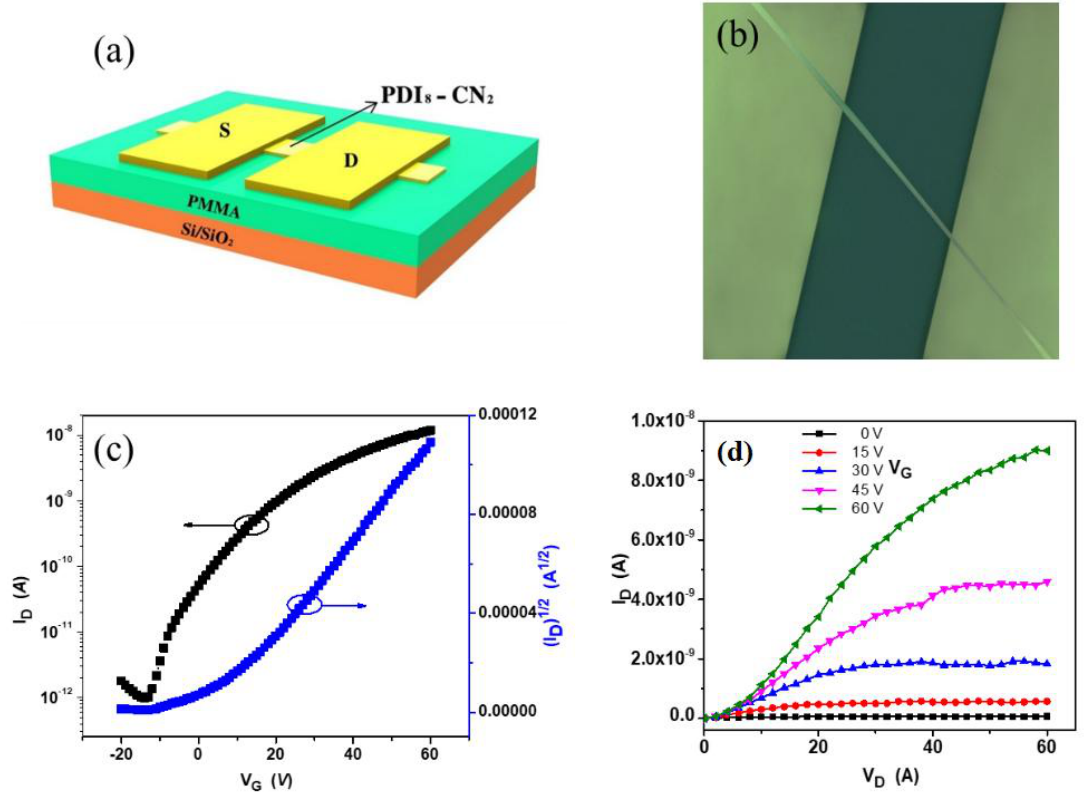
Figure 5. ( a ) Schematic diagram and ( b ) optical image of the device with an individual nanowire. ( c ) Transfer and ( d ) output characteristics (channel length, L = 24 µ m; channel width, W = 0.6 µ m) of the nanowire-based transistor.